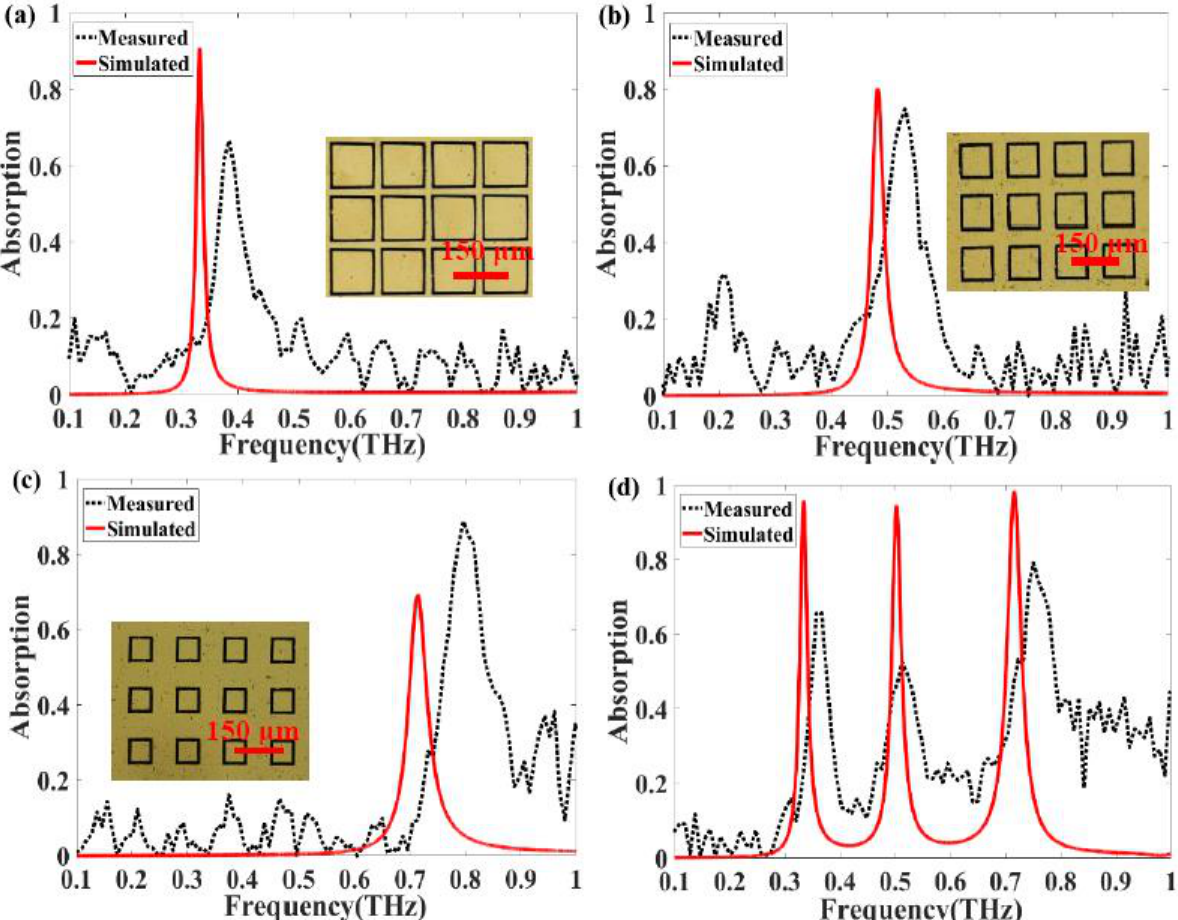
Figure 9. Simulated and measured spectra of absorber structures: ( a ) outer square ring resonator; ( b ) middle square ring resonator; ( c ) inner square ring resonator; ( d ) resonator with three concentric square rings.